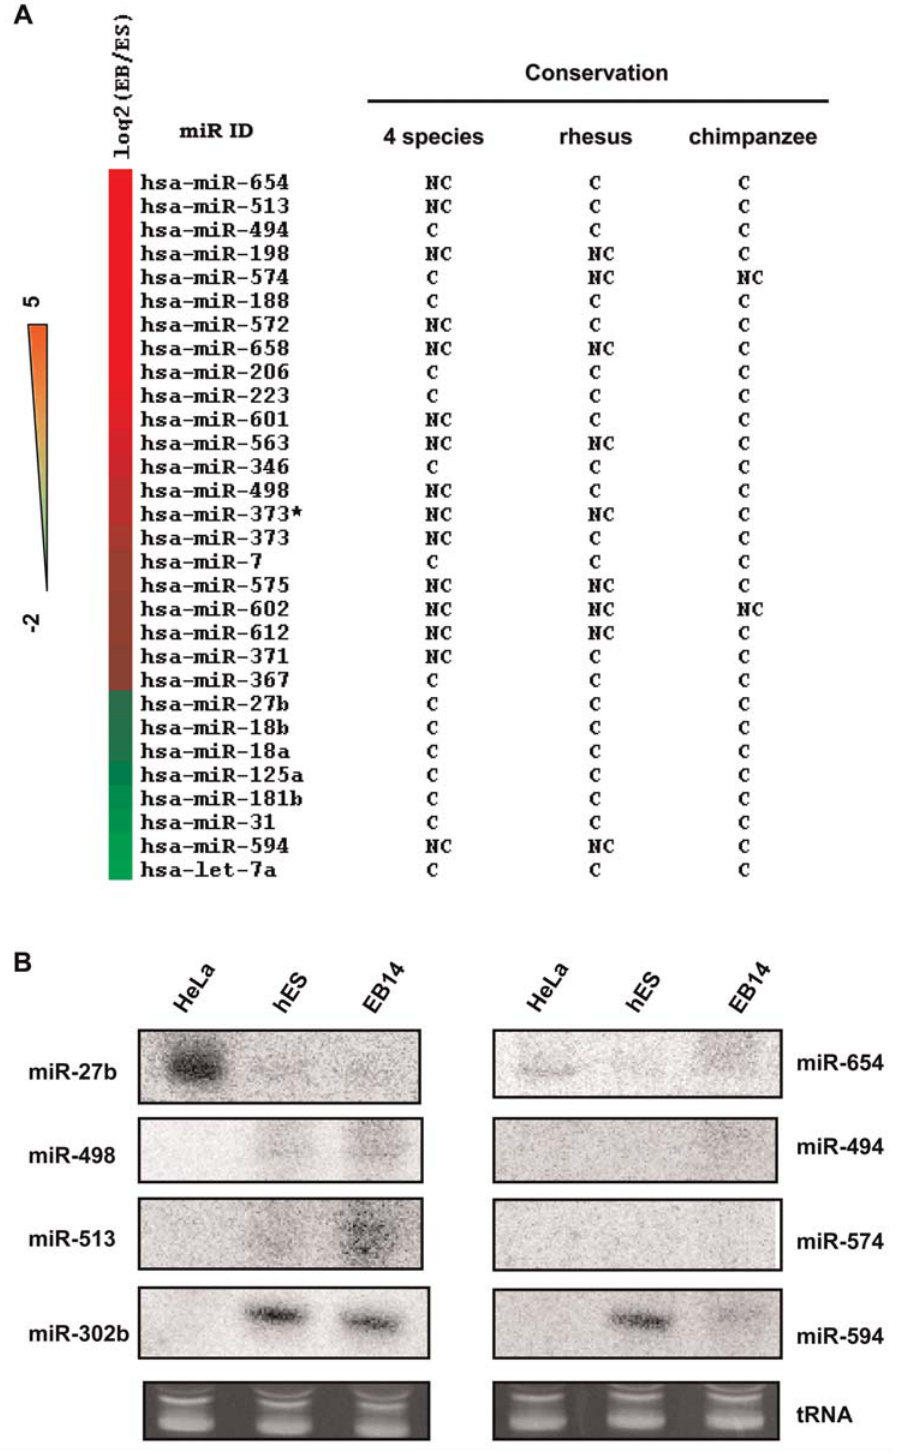
Figure 3. (A) Expression of a unique set of miRNAs changes during differentiation of human ES cells (hES) into embryoid bodies (EBs). miRNA expression was analyzed in hES cells and EBs after 14 days of differentiation. miRNA expression is arranged by log2 ratio in hES cells/EBs (EB/ES) for 30 of , 276 miRNAs whose log2 ratio . 1. Red indicates upregulated miRNAs in EB14 relative to their expression in ES cells and green indicates downregulated miRNAs. Conservation of miRNAs was analyzed as described in Fig 1 (Table S3, supplementary material). (B) Northen analysis of miRNA expression in hES cells and EBs. Total RNA was prepared from hES and 14-days embroid bodies (EB14). RNAs (10 ug) were loaded onto gels and miRNA bands were resolved by 14% denaturing gels. miRNAs were hybridized with various 32 P labeled specific DNA probes as indicated. Specific bands were visualized by phosphoImager. tRNA band shows the loading control.